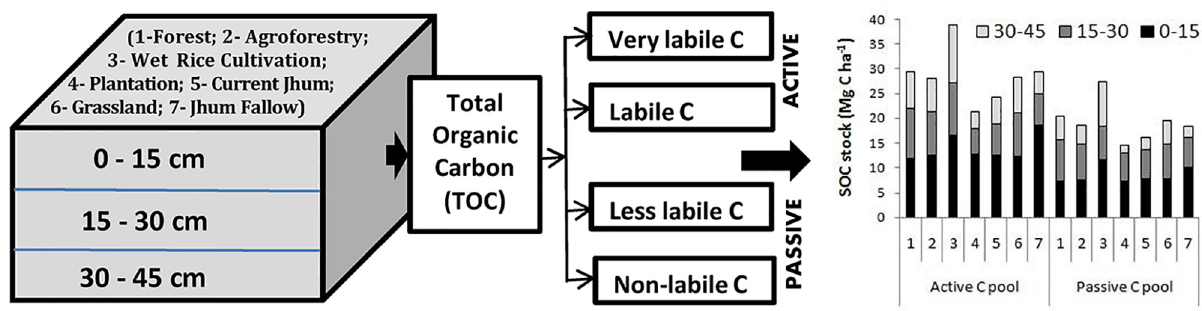
Fig 1. Distribution of active and passive soil carbon at three soil depths in different land use systems.